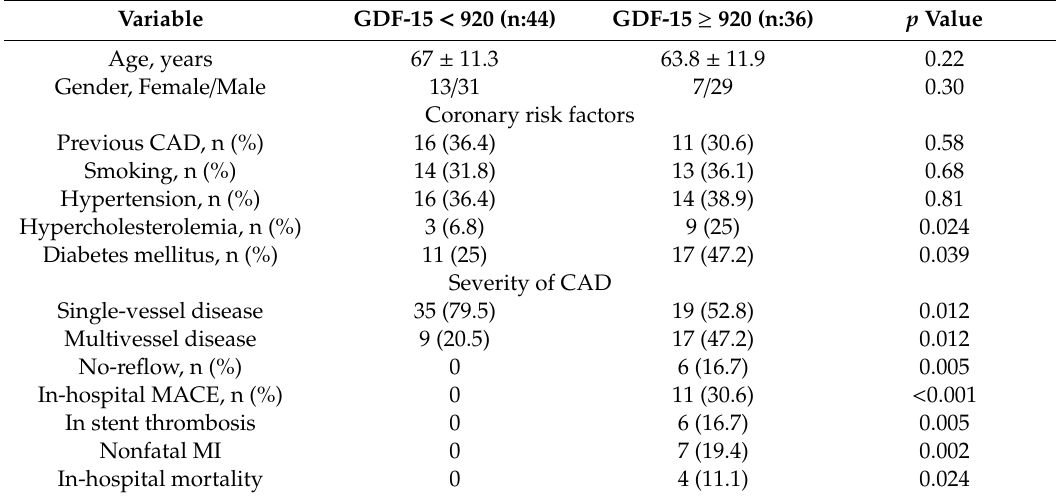
Table 2. Baseline risk factors and in-hospital MACE stratified by GDF-15 levels.